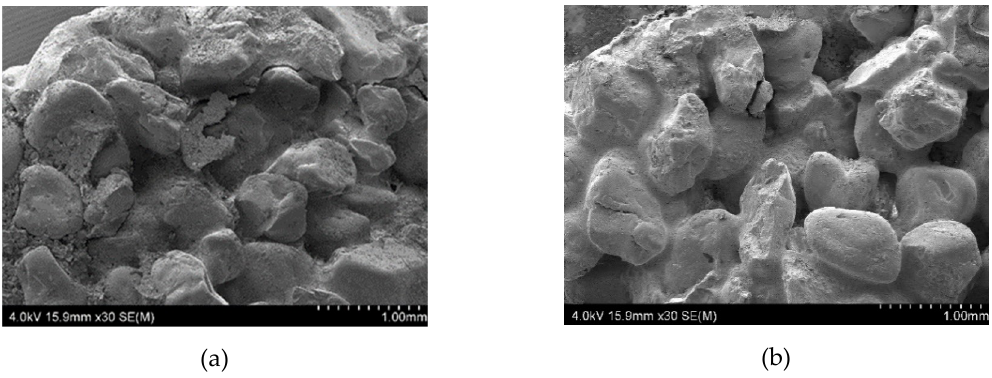
Figure 2. The scanning electron microscopy (SEM) morphology of the ceramic mold samples: ( a ) Sample Q1 and ( b ) Sample Q2.